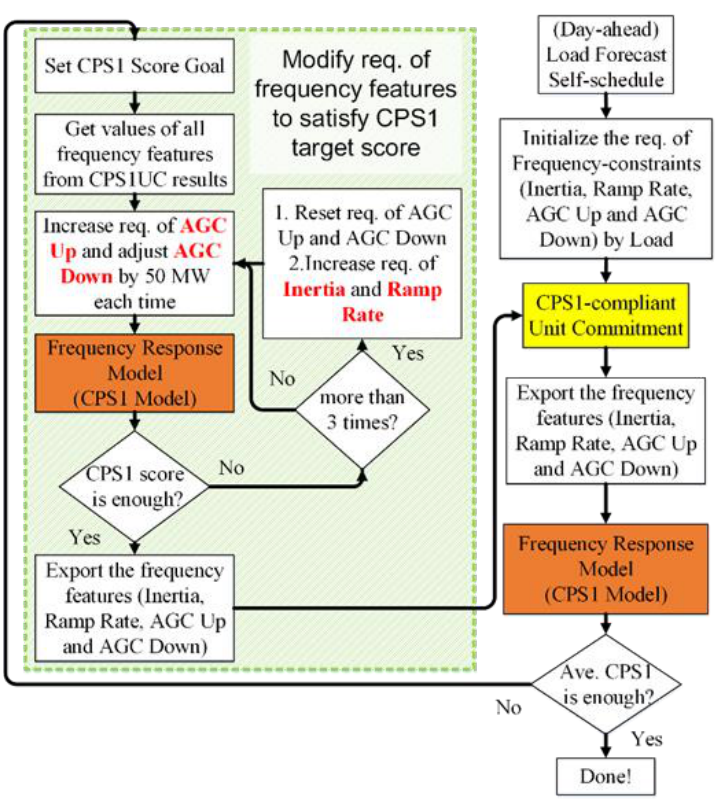
Figure 8. Integration of the proposed CPS1 model with the UC program.